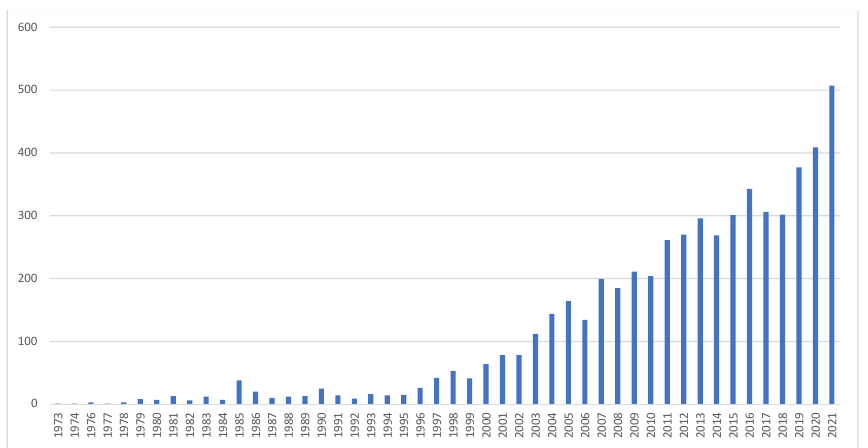
Figure 1. Scientific production on fire management indexed in Scopus per year (1973–2021).